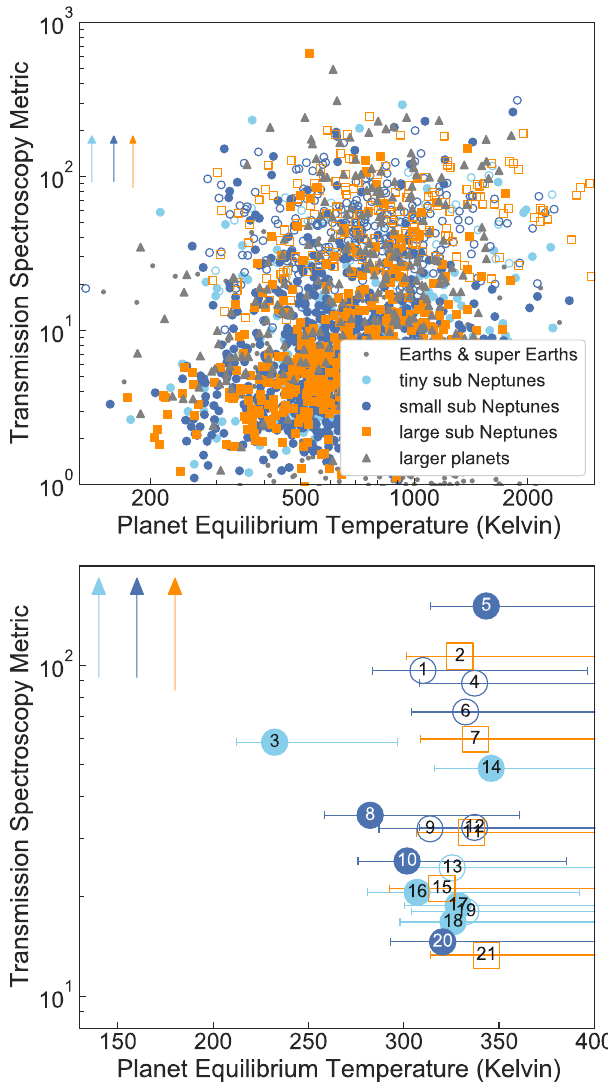
Figure 6. Temperate sub Neptune exoplanets and planet candidates suitable for hosting an aerial biosphere (blue-shaded region). The atmospheric transmission spectroscopy metric (TSM; y axis) vs. planet equilibrium temperature in Kelvin ( T eq ; x axis). Planet categories are indicated as follows: grey circles for Earths and super Earths (<1.5 R Earth ); light blue circles for tiny sub Neptunes (1.5 to 1.8 R Earth ); blue circles for small sub Neptunes (1.8 to 2.75 R Earth ); orange squares for large sub Neptunes (2.75 to 4 R Earth ); and grey triangles for planets larger than sub Neptunes (>4 R Earth .). Confirmed sub Neptunes have filled symbols, while planet candidates (TESS Objects of Interest, TOIs) have unfilled symbols. Central values stem from assuming zero Bond albedo and full heat-recirculation (see Equation (1)). Error bars reflect different Bond albedo and heat-recirculation assumptions (Equation (1); with Bond albedo, A B , of 0 or 0.3, and correction factor, f , of ¼ or ⅔.). The three arrows show the recommendation for a minimum TSM [147] color coded for different planet sizes (TSM > 92 for 1.5 < R p < 2.75 and TSM > 84 for R p > 2.75). The blue-shaded region (TSM > 10 and T eq < 320 K) indicates the favorable sub Neptune parameter space for liquid water clouds, in terms of observability and cold enough temperatures. The prime candidates falling into this region include nine confirmed planets LHS 1140 b, LP 791-18 c, K2-18b, K2-9 b, TOI-1266 c, K2-3 d, Kepler-560 b, K2-133 e, K2-125 b as well as 12 candidate TOIs (see Figure 7). All data shown rely on estimated equilibrium temperatures, estimated transmission spectroscopy metrics, and some planets and candidates rely on estimated planet masses, described in the main text. The right-side panel is a zoom in of the left-side panel. The numbers indicate a ranking described in the Figure 7 caption. Data taken from the NASA Exoplanet Archive and the TOI Catalog on 28 January 2021.